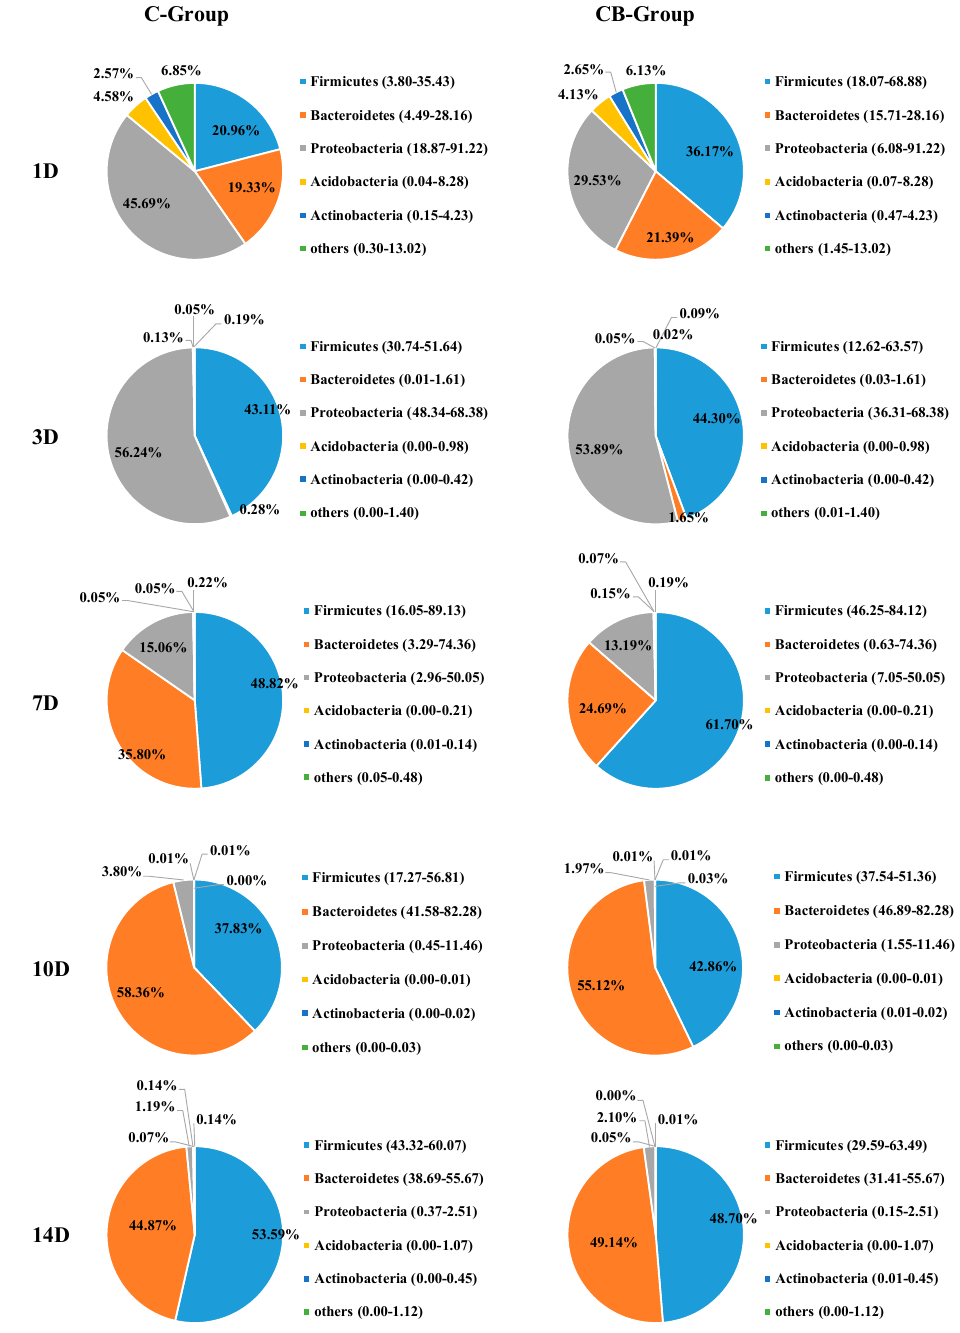
Figure 4. Phylum-level bacterial composition of the cecum microbiota between the C group and the CB group. C group, control group; CB group, C. butyricum group. 1D, 3D, 7D, 10D, and 14D represent 1st day, 3rd day, 7th day, 10th day, and 14th day of the present experiment, respectively.